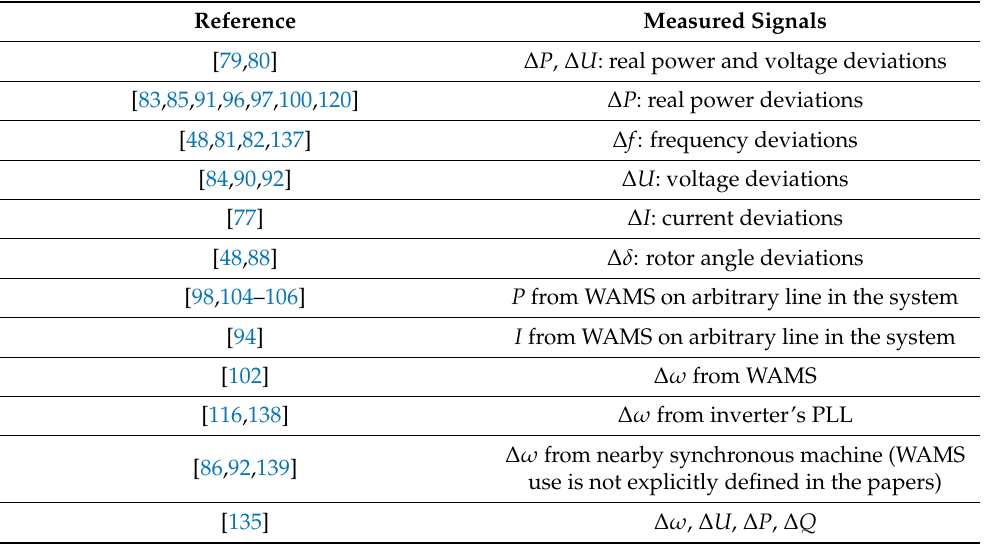
Table 1. Feedback signals for POD.